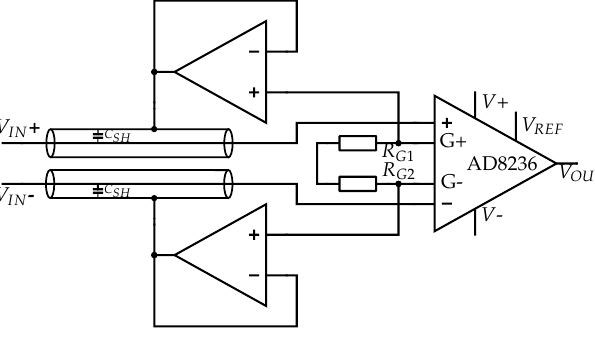
Figure 6. A separate active shield for each signal line decreases parasitic capacities and protects against external